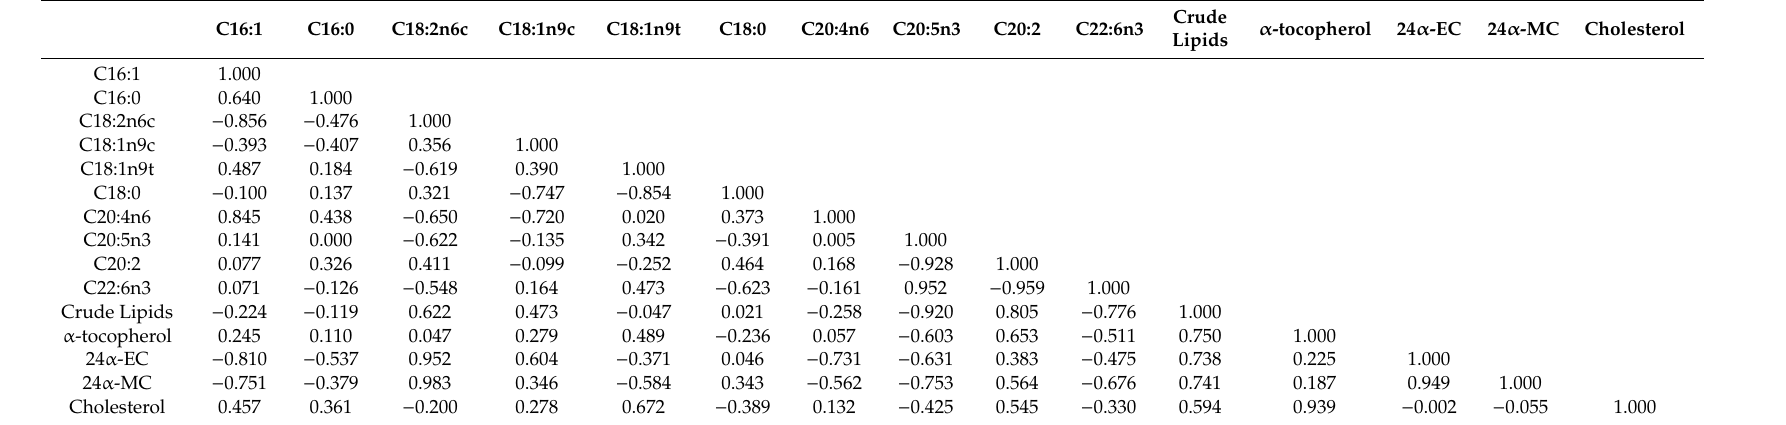
Table 6. Correlation between major lipophilic compounds of studied shrimp